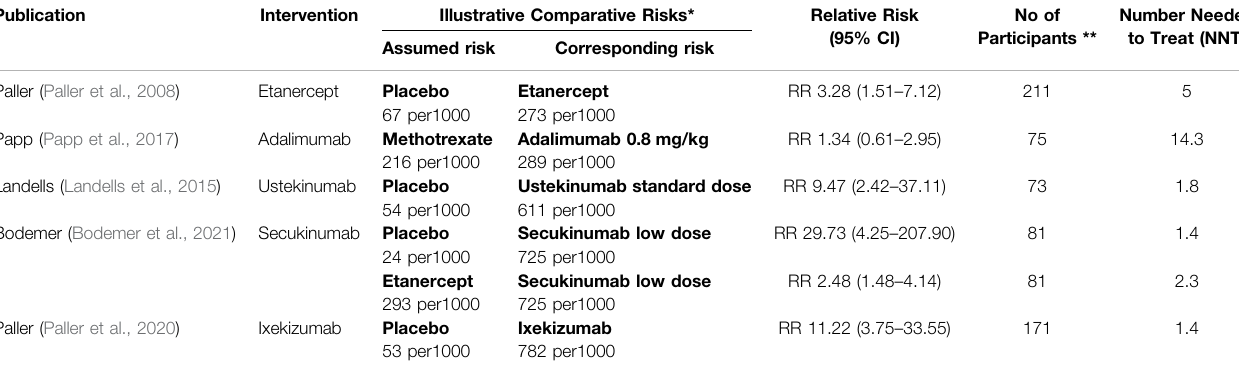
TABLE 4 | Ef fi cacy outcome: PASI 90. Active treatment (intervention) compared to placebo or active comparator (methotrexate, etanercept). Publication Intervention Illustrative Comparative Risks* Relative Risk